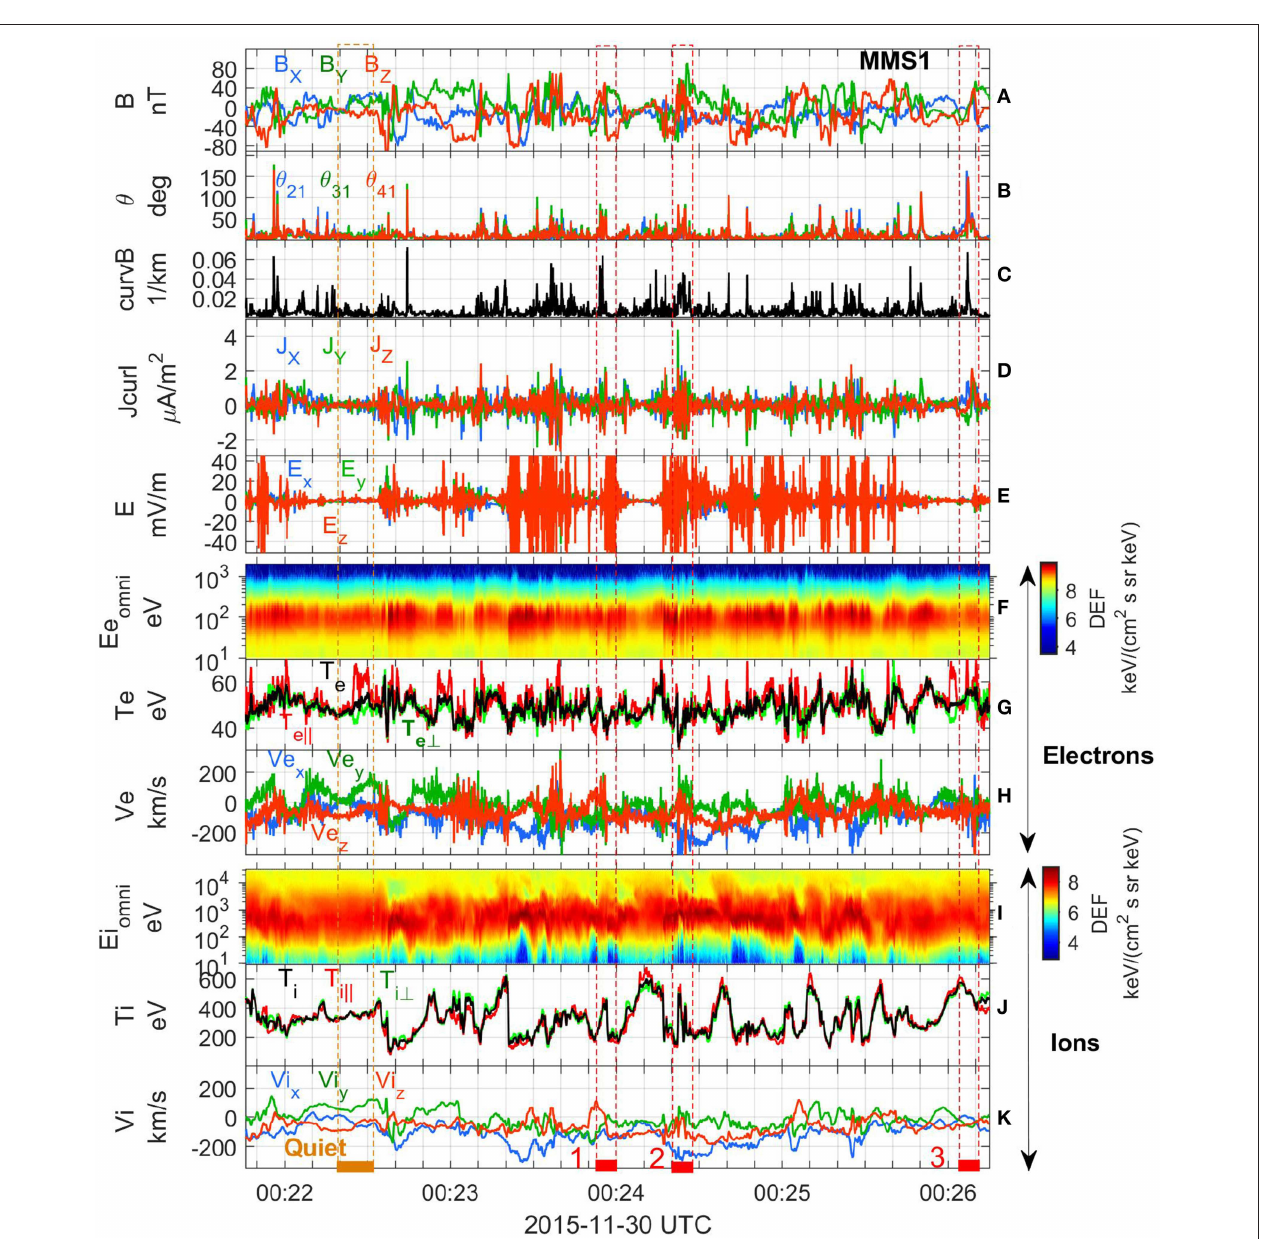
FIGURE 1 | Overview of the event. (A) magnetic field components in GSE ( B X , B Y , B Z ); (B) magnetic shear angle between spacecraft pairs θ ; (C) magnetic field curvature curvB; (D) curlometer current density components in GSE ( J X , J Y , J Z ) (E) electric field components in GSE ( E X , E Y , E Z ); (F) omnidirectional electron differential energy flux spectrogram; (G) electron temperature ( T e ), parallel ( T e || ) and perpendicular ( T e ⊥ ) to magnetic field electron temperatures; (H) electron velocity components in GSE ( Ve X , Ve Y , Ve Z ); (I) omnidirectional ion differential energy flux spectrogram; (J) ion temperature ( T i ), parallel ( T i || ) and perpendicular ( T i ⊥ ) to magnetic field ion temperatures; (K) ion velocity components in GSE ( Vi X , Vi Y , Vi Z